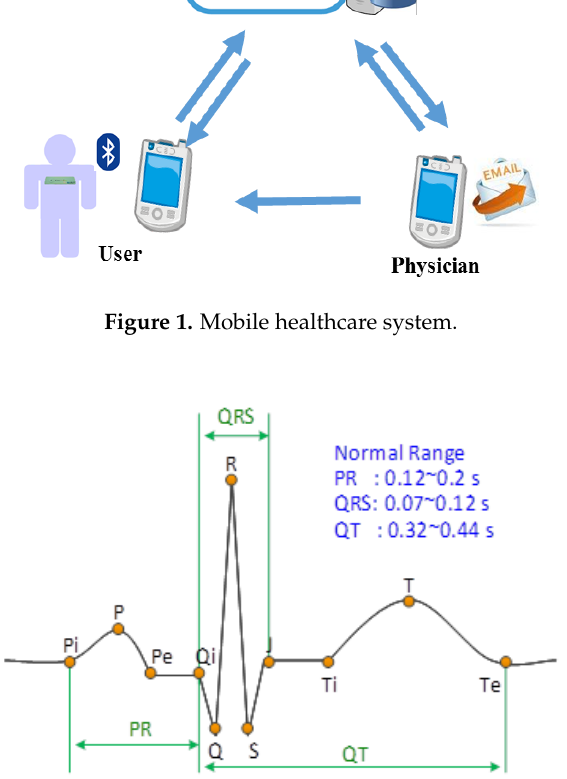
Figure 2. Typical ECG waveform of a cardia cycle (normal sinus rhythm in Lead II).